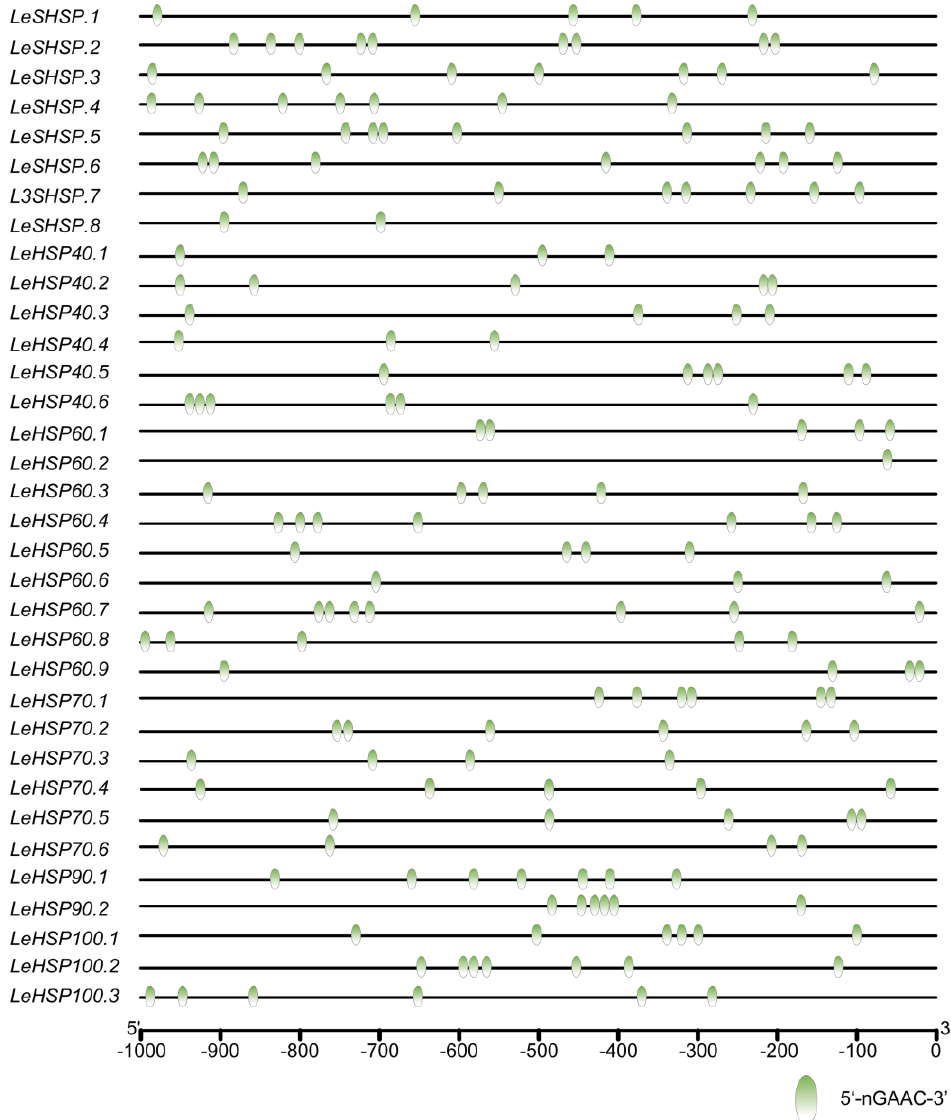
Figure 4. Predicted binding site of HSF in LeHSP promoters. Promoter sequences ( − 1000 bp) of 34 LeHSP genes were used to predict the HSEs (5 − nGAAC −3′ ) using TBtools. The location of HSEs can be inferred according to the scale at the bottom.